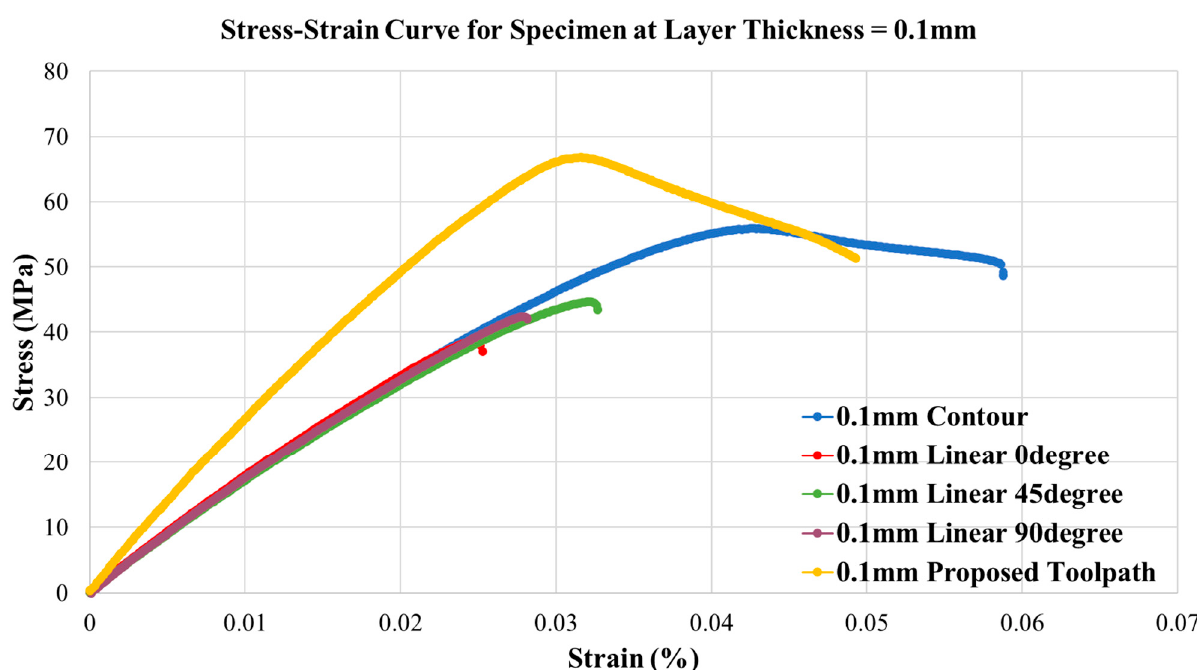
Figure 8. Load extension graph for all print specimens at layer thickness = 0.1mm.